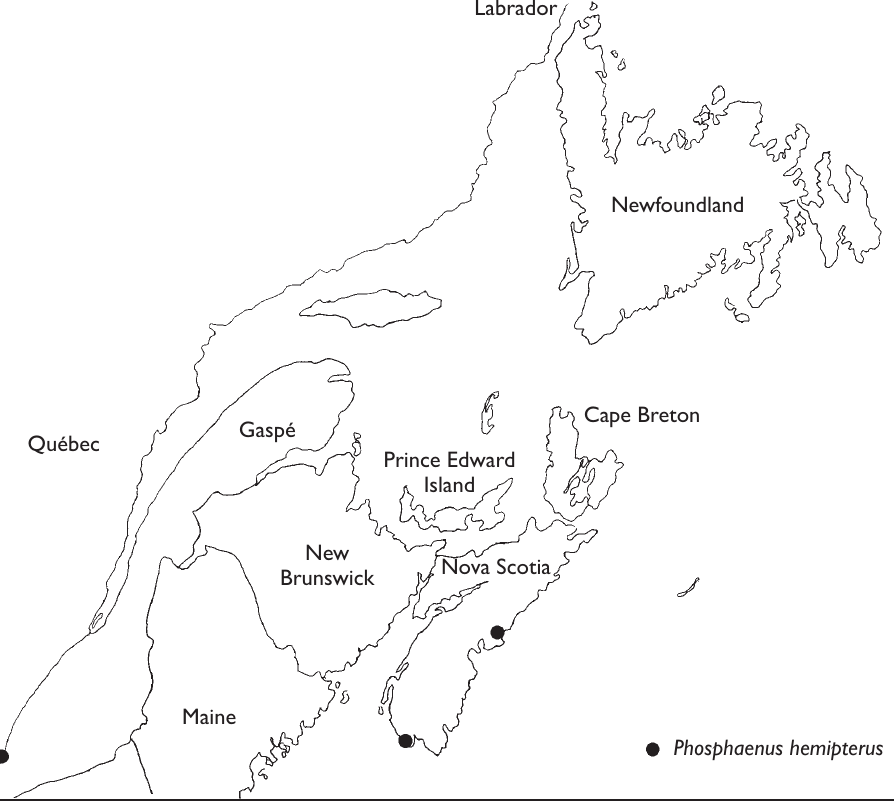
Figure 7. Collection localities for Phosphaenus hemipterus in North